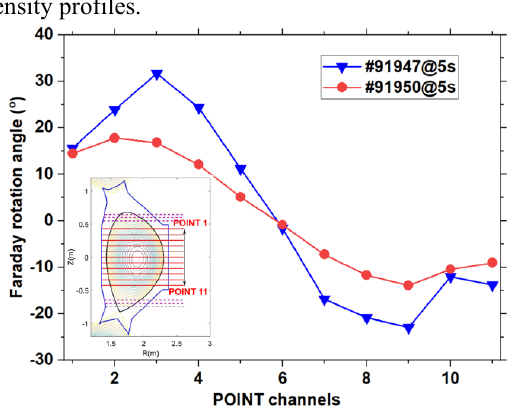
Fig. 8. Line-integrated Faraday rotation angle versus channels measured by POINT diagnostic. The optical layout of the 11 channels is also shown.